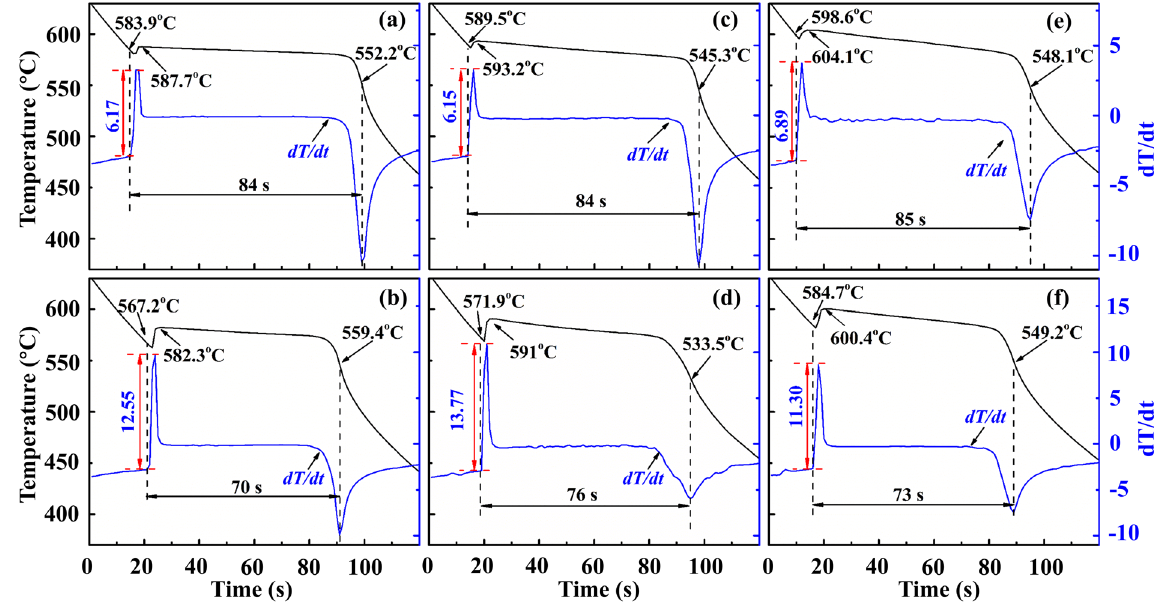
Figure 3. Cooling curves for Bi 2 Te 3 − x Se x liquid alloys. The temperature indicated by the first arrow from the left side of each picture is the nucleation temperature, T N . The second arrow indicates the recalescence temperature, T G . The red double sided arrow shows the height of the first peak for dT / dt curve, Δ h . The black double sided arrow shows the solidification time. ( a ) x = 0.3-A; ( b ) x = 0.3-B; ( c ) x = 0.45-A; ( d ) x = 0.45-B; ( e ) x = 0.6-A; ( f ) x =